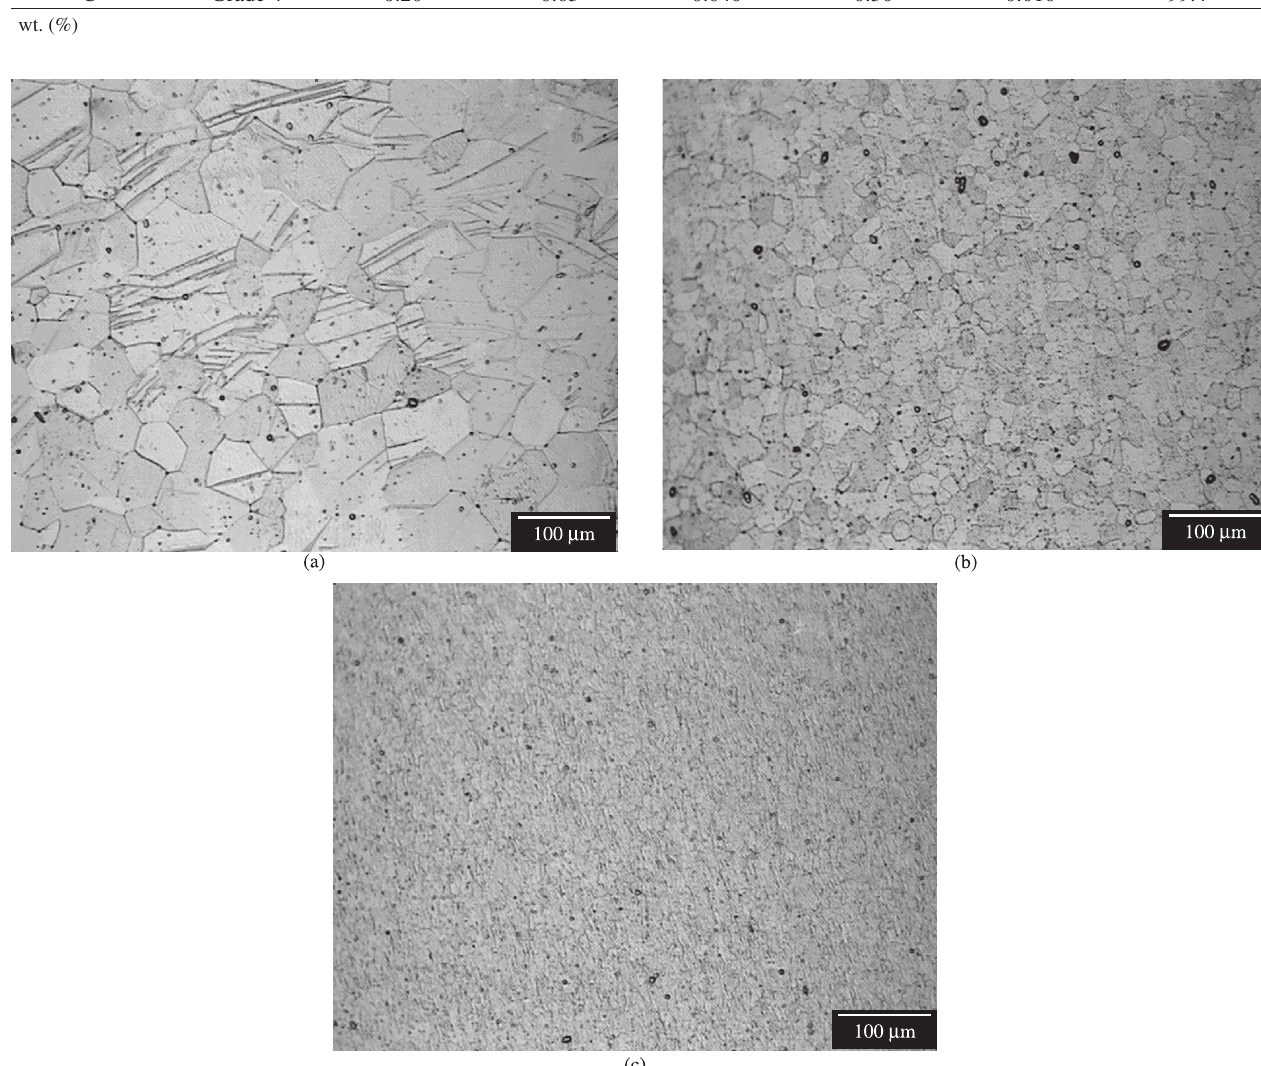
Figure 1. Microstructures of (a) A, (b) B and (c) C